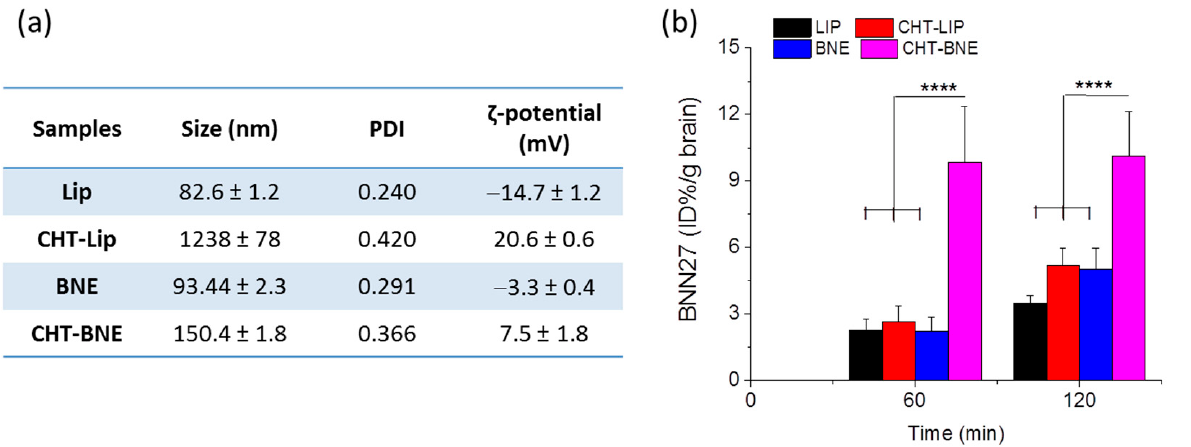
Figure 10. ( a ) Physicochemical properties of the formulations used in the in vivo disposition study. ( b ) Brain disposition of BNN27 1 and 2 h post-intranasal administration of the BNN27 loaded liposomal and NE formulations. Each value is the mean of at least three independent samples. ****: p ≤ 0.0001.